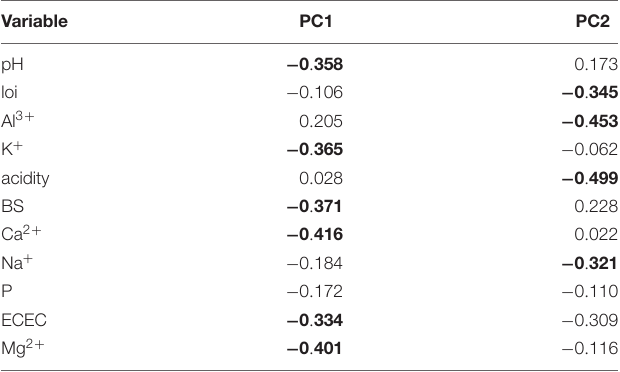
TABLE 2 | Correlations between soil variables and the two axes generated from principal component analysis. Variable PC1